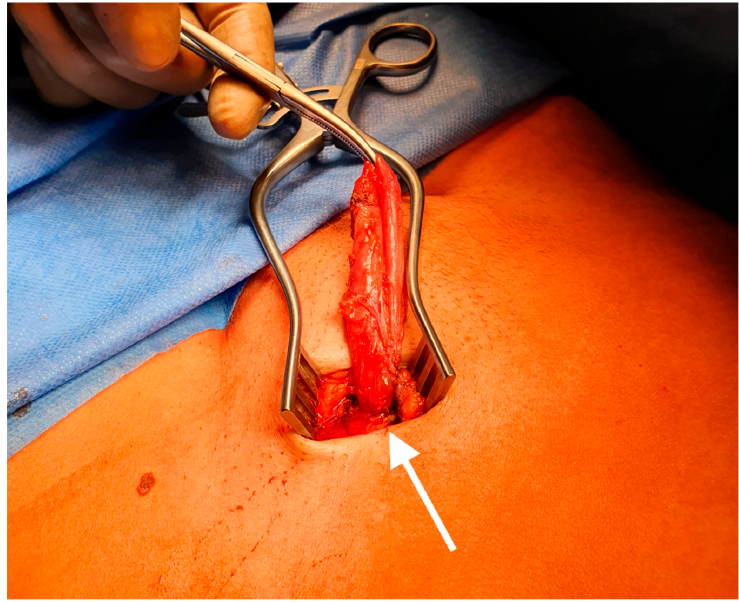
Figure 4. Intraoperative picture of a hydrocele of the canal of Nuck. The round ligament (white arrow).